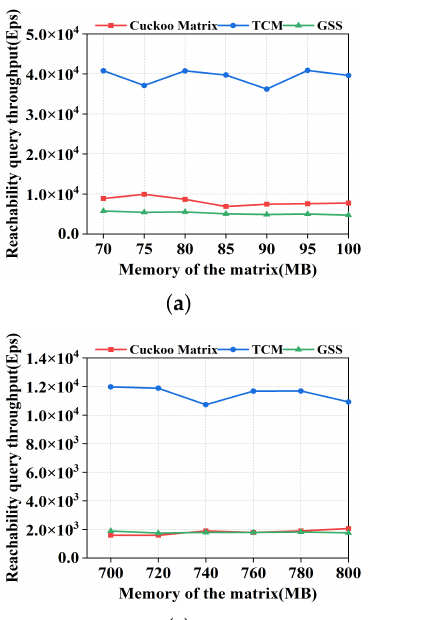
Figure 8. True negative recall of reachability queries. ( a ) Skitter. ( b ) DBLP. ( c ) Orkut. ( d ) Wiki.